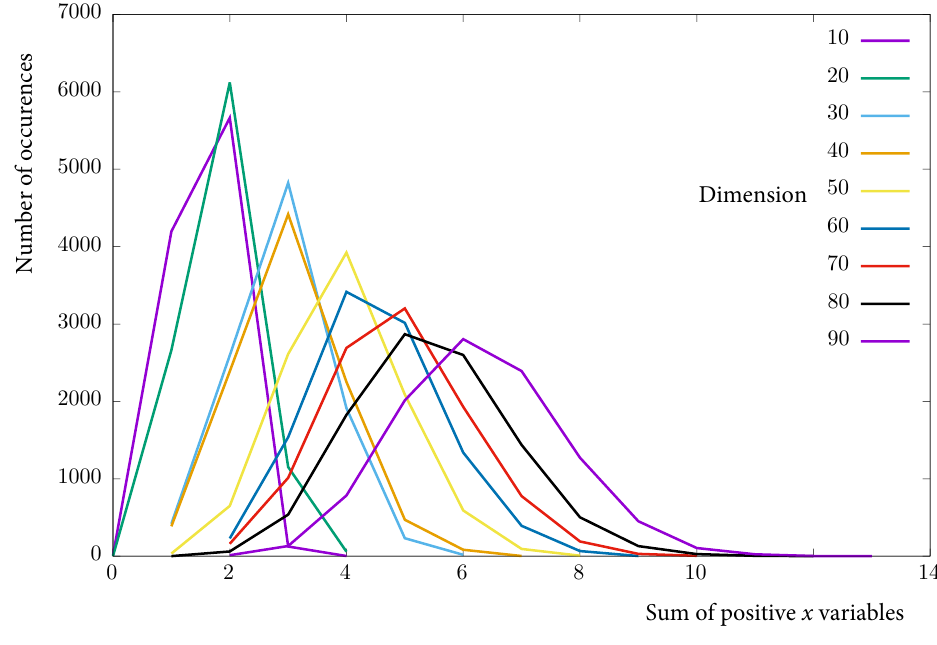
Figure 16. Dependence of the quality of the constraint embedding on the length of the vector x (number of problem variables x i ). Results for sizes 10,20,30, . . . ,90 are shown in different